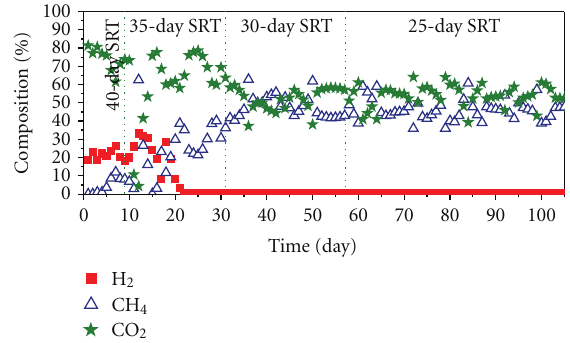
Figure 5: Biogas composition expressed as